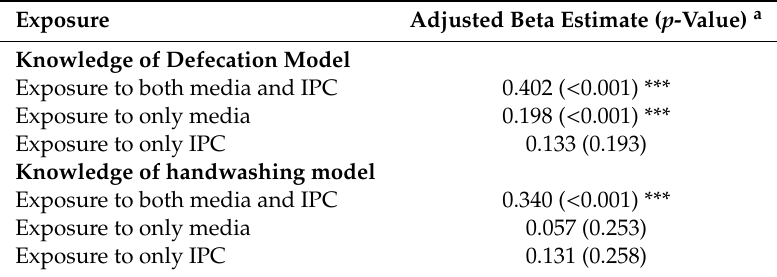
Table 4. Regression analysis with knowledge for defecation and handwashing.